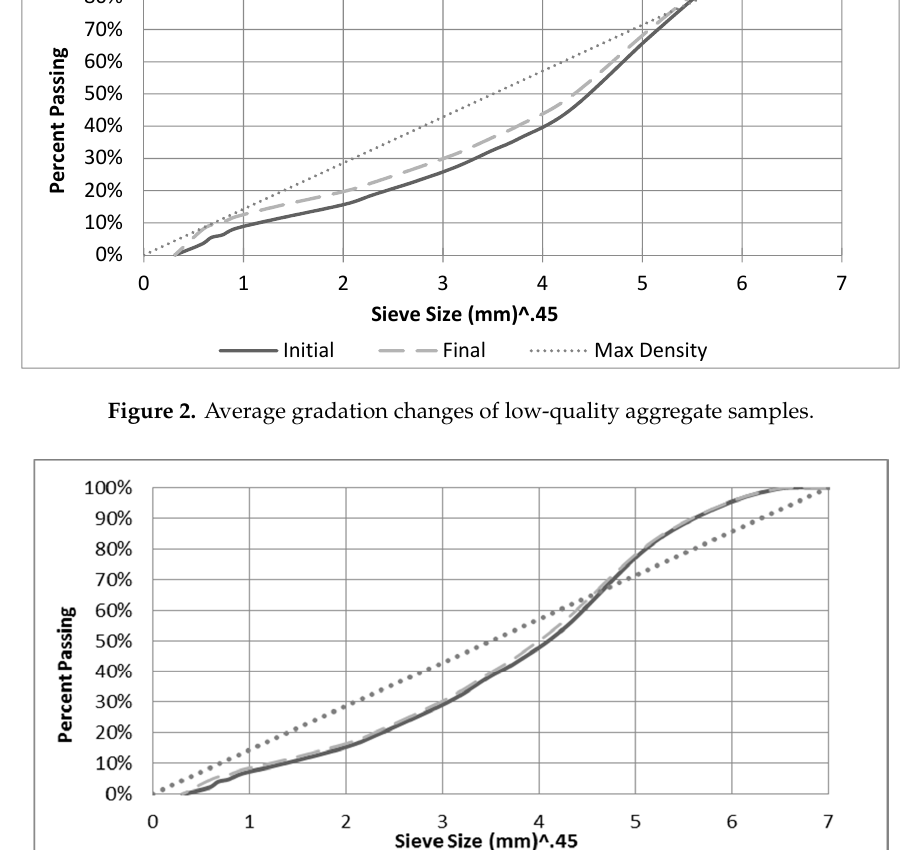
Figure 5. Changes in mass of high-quality aggregate sample averages by loading intensity. 221